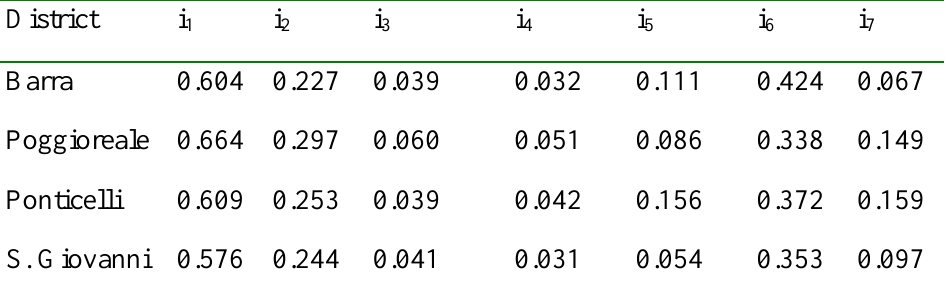
Table 2. Input data given for the four subzones